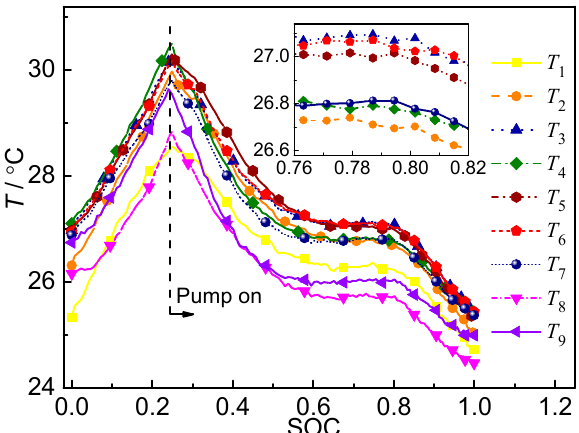
Figure 3. The measured temperatures of the battery module during 0.5 C charging. The pump’s frequency is 21 Hz when